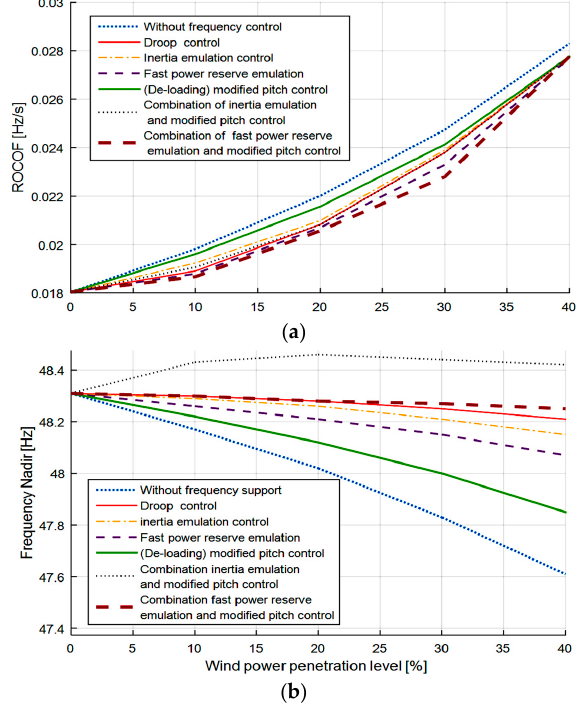
Figure 22. ( a ) ROCOF; and ( b ) FN vs. wind power penetration level in high wind speed case.